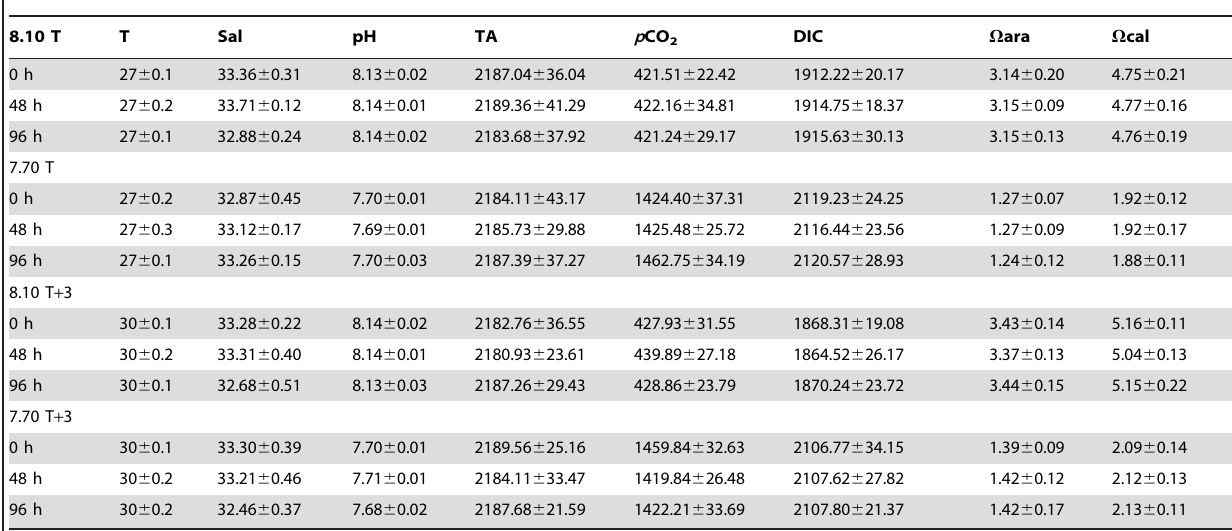
Table 1. Parameters of the carbonate system in each